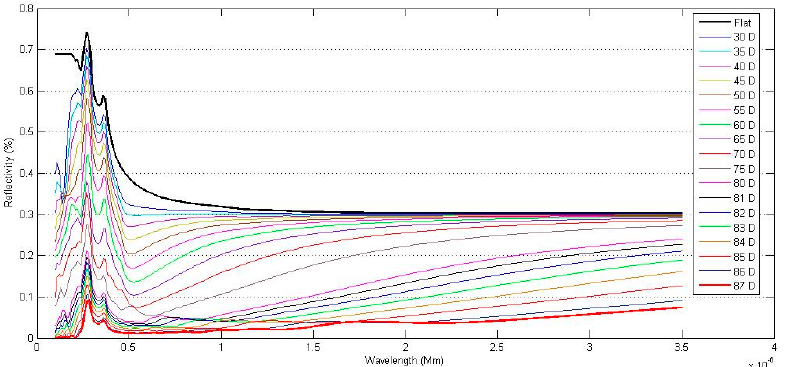
Figure 8. Simulation results for spectral reflection of surfaces with different microstructures by changing the leg angle. D stands for degree.